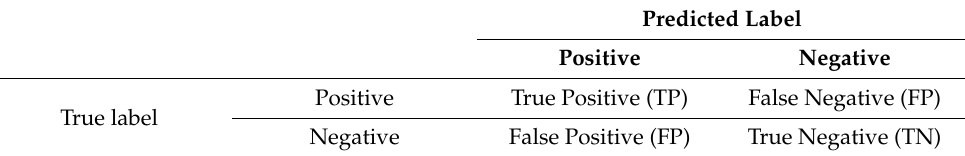
Figure 7. Ranking of model accuracy scores. Table 2. Confusion matrix results.